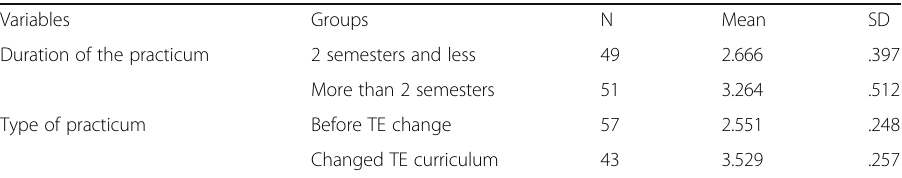
Table 7 Descriptive statistics